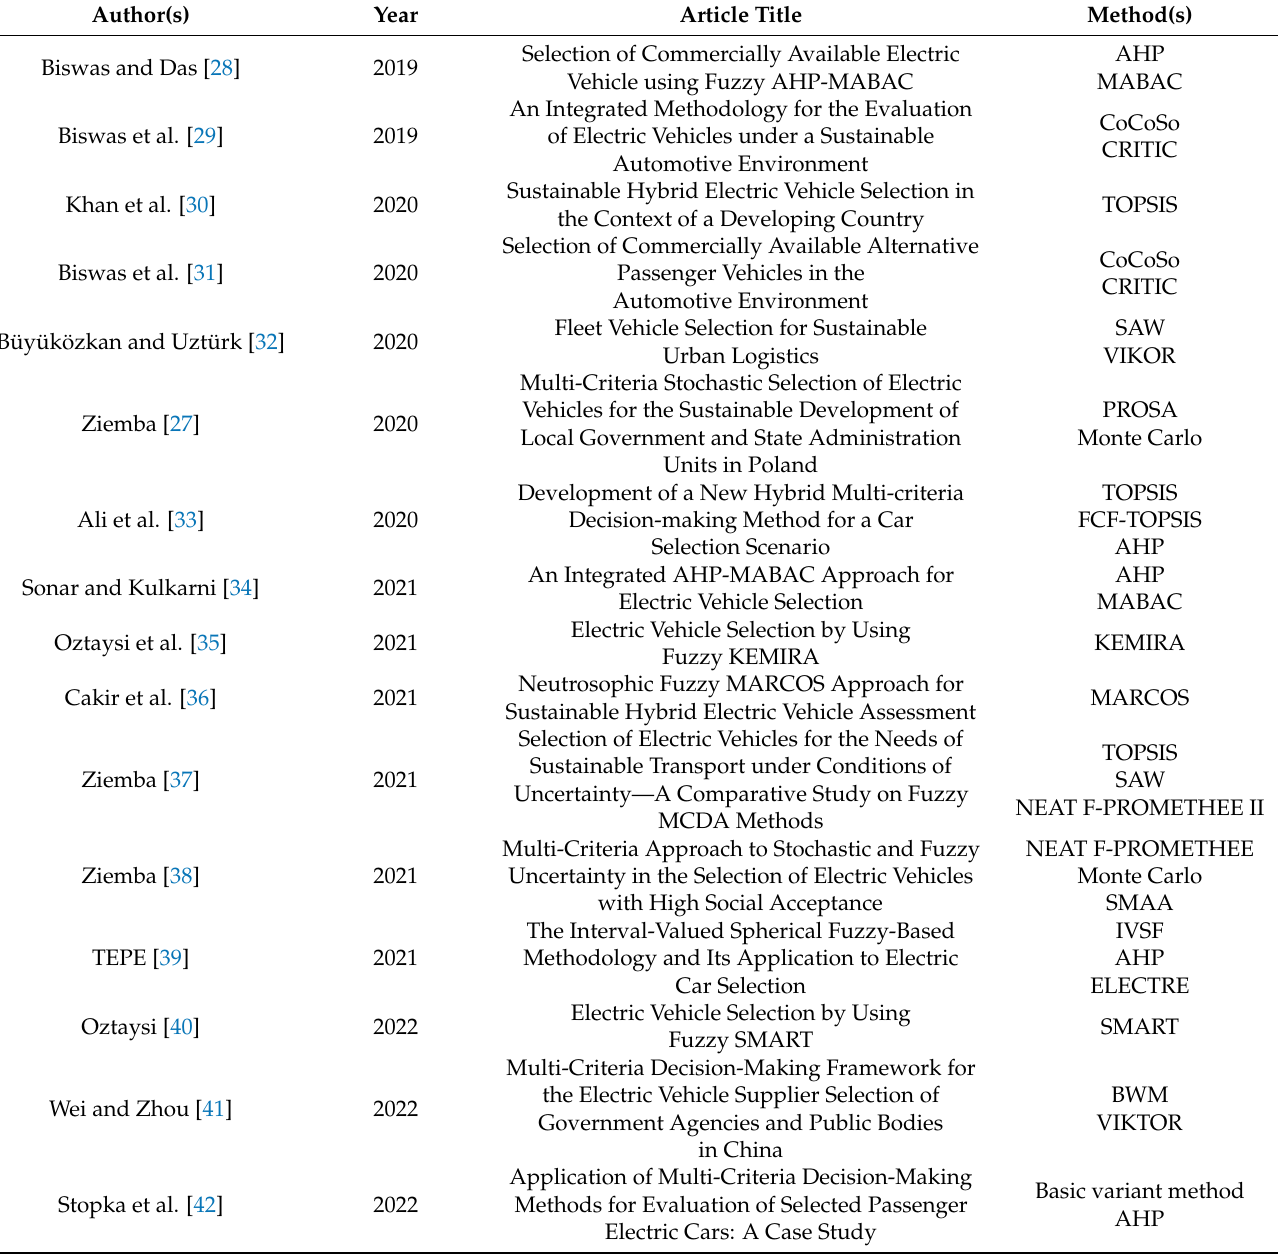
Table 1. The application of multi-criteria decision-making (MCDM) methods in the selection of